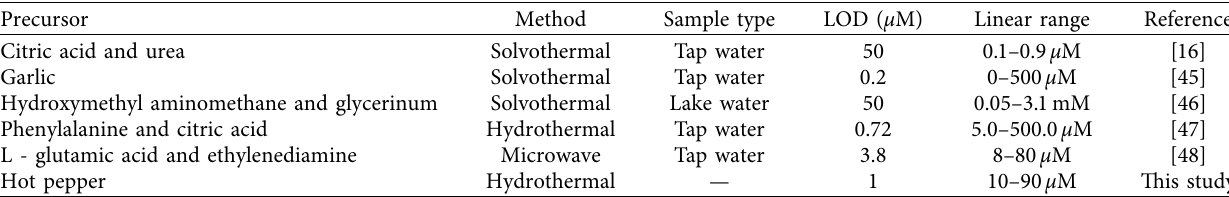
Table 2: Comparison of diferent carbon dots sensors for the determination of Fe +3 .